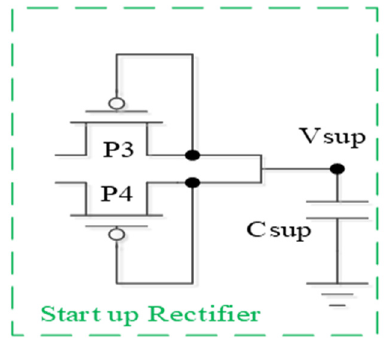
Figure 8. Start Up Rectifier [9].